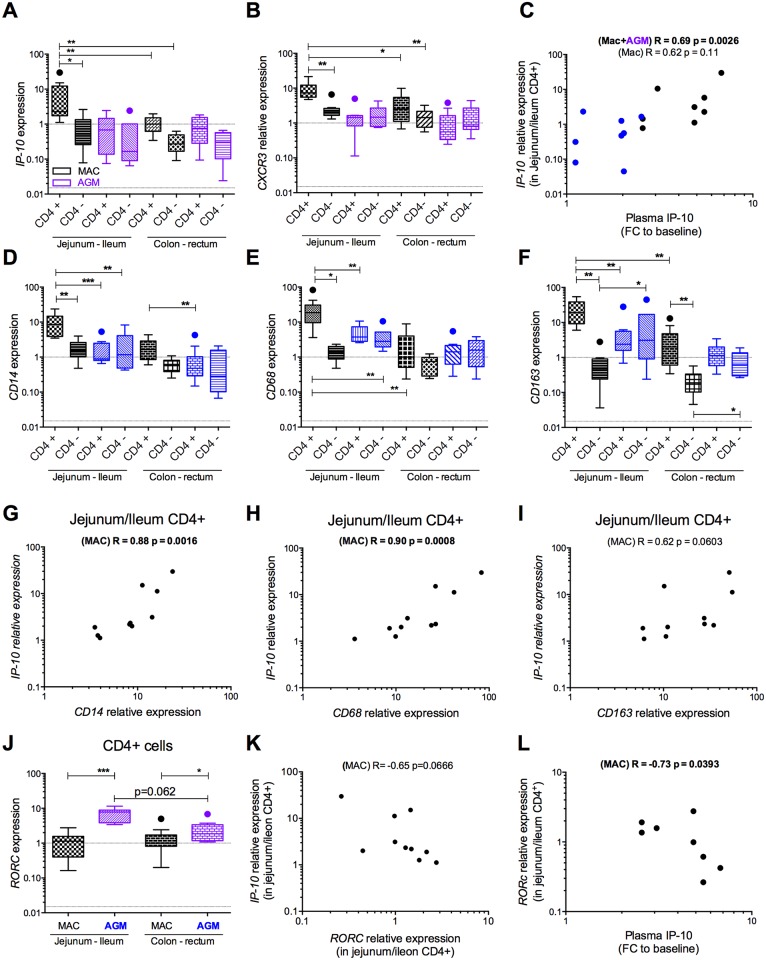
Cellular gene expression profiles in the intestine.
A-L. Cellular gene expression levels were evaluated in CD4neg and CD4pos leukocytes from 4 distinct segments of the intestine of SIV+ non-human primates, i.e. rhesus macaques (n = 5) and African green monkeys (n = 5) on day 65 p.i. Raw values are represented. A. IP-10 gene expression. B.
CXCR3 gene expression. C. Correlation between blood IP-10 levels and IP-10 gene expression in the upper intestine. IP-10 gene expression levels were normalized to expression in the rectum of each animal. IP-10 levels in blood are expressed as the fold change from baseline. (D-F) CD14, CD68 and CD163 gene expression levels were evaluated in CD4neg and CD4+ leukocytes from different segments of the digestive tract of SIV+ non-human primates obtained at necropsy (day 65 p.i.). G. Correlation between CD14 and IP-10 gene expression levels in the small intestine. H. Correlation between CD68 and IP-10 gene expression levels in the small intestine. I. Correlation between CD163 and IP-10 gene expression levels in the small intestine. J.
RORc gene expression levels in CD4+ leukocytes from the small intestine. K. Correlation between RORc and IP-10 gene expression levels. L. Correlation between blood IP-10 levels and RORc gene expression levels in the small intestine. MAC = SIV-infected rhesus macaques (black), AGM = SIV-infected African Green Monkeys (blue).